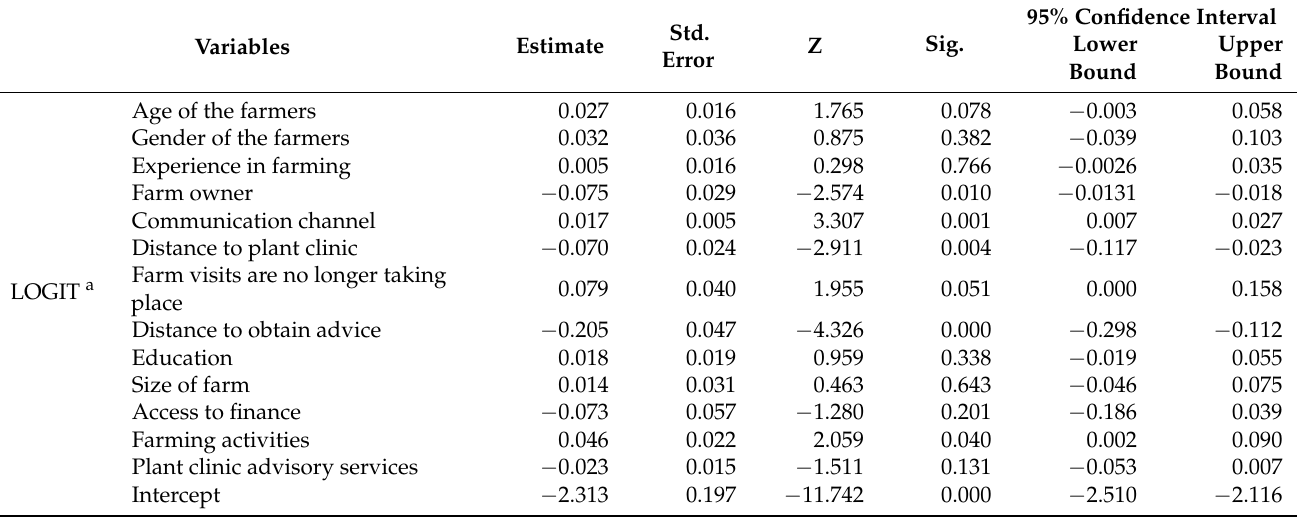
Table 5. Parameter estimates of logit regression model of factors influencing smallholder farmers’ accessibility to plant health clinic advisory services (n =